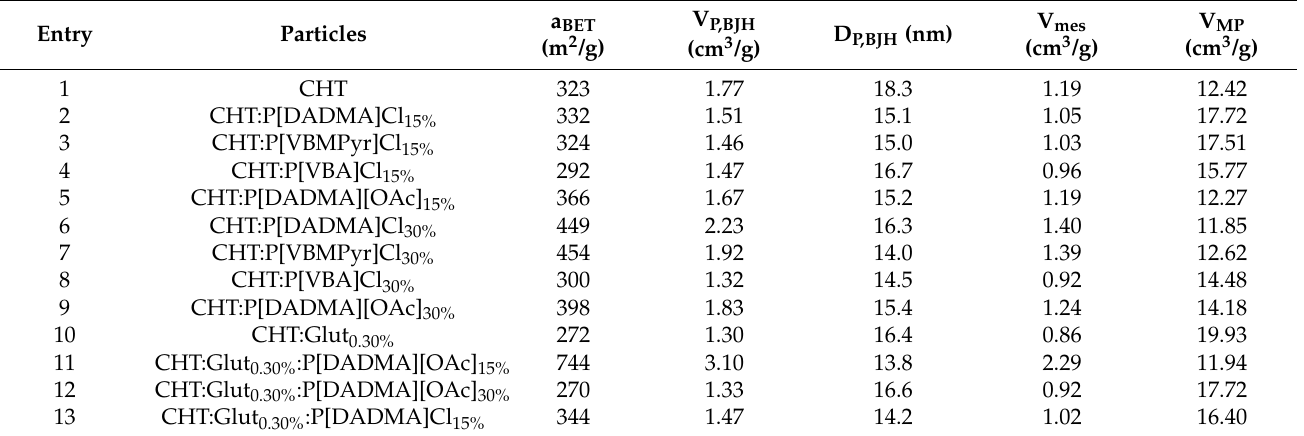
Table 3. Textural properties evaluated by nitrogen adsorption-desorption tests of the chitosan aerogel particles. Notation: a BET , specific surface area by the BET method; V P,BJH , overall specific pore volume obtained by the BJH method; V mes , specific mesopore volume; V MP , specific macropore volume; D P,BJH , mean pore diameter by the BJH